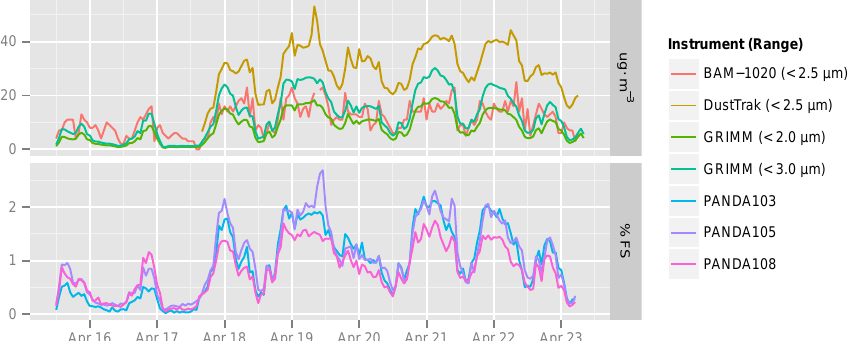
Fig. 1. Hourly data collected between 15 April 2013 and 23 April 2013 at the West Oakland regulatory monitoring site. Top panel: PM 2 . 5